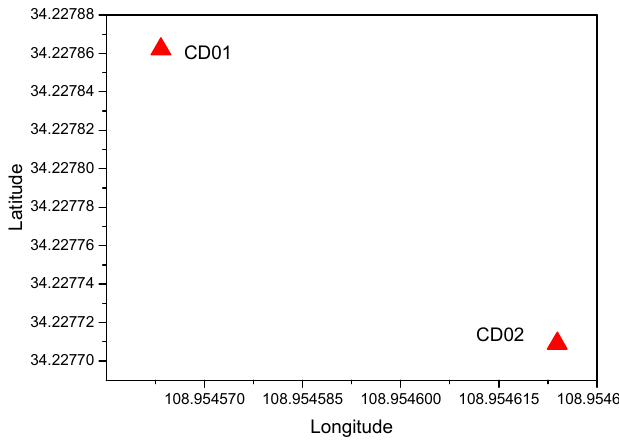
Figure 3. Distribution of stations CD01 and CD02.